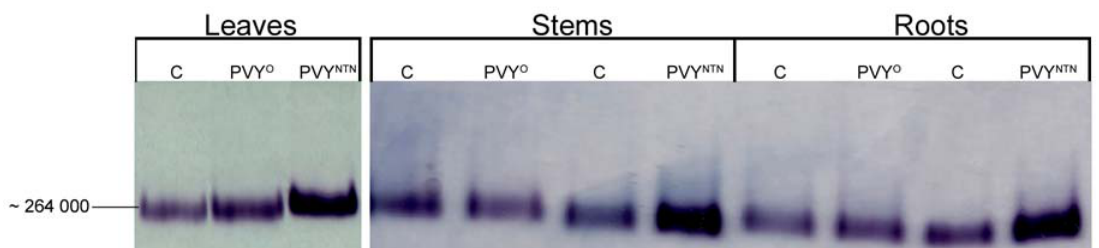
Figure 4. Detection of NADP-ME in 10% polyacrylamide gel after non-denaturating electrophoresis. Control (marked as C), PVY O and PVY NTN infected leaves, stems and roots of Nicotiana tabacum L. plants were analysed. Samples were collected at the maximal symptoms occurrence (11 th day after PVY O inoculation and 13 th day after PVY NTN